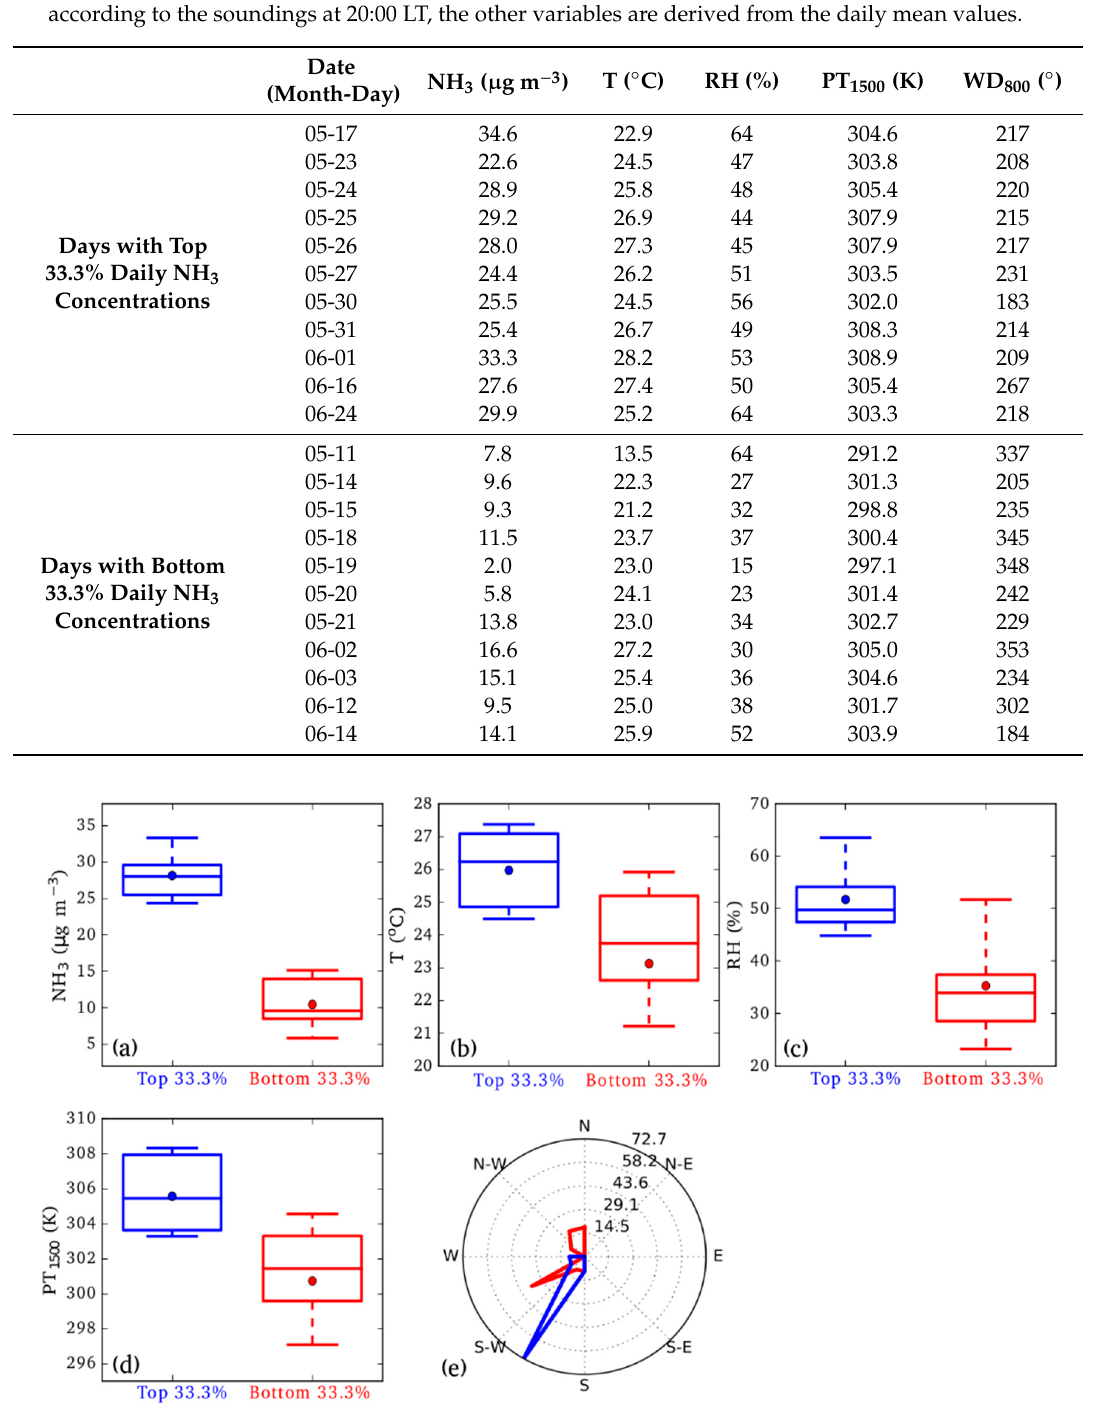
Figure 3. Box-whiskers plots showing different characteristics between the top 33.3% and bottom 33.3% NH 3 concentrations during the dry conditions from 11 May to 24 June, 2015, including ( a ) NH 3 concentrations, ( b ) 2-m T, ( c ) 2-m RH, and ( d ) 1500-m PT. The central box represents the values from the lower to upper quartile (25th to 75th percentile). The vertical line extends from the 10th percentile to the 90th percentile value. The middle solid line represents the median, and the dot represents the mean value. In ( e ), wind rose diagram based on the 800-m horizontal wind associated with the top 33.3% (in blue) and bottom 33.3% (in red) NH 3 concentrations in Beijing are shown. Except for that the 1500-m PT and 800-m wind are shown according to the soundings at 20:00 LT, the other variables are derived from the daily mean values. 3.2. Case Study on the Regional Transport of NH 3 to Beijing using WRF-Chem